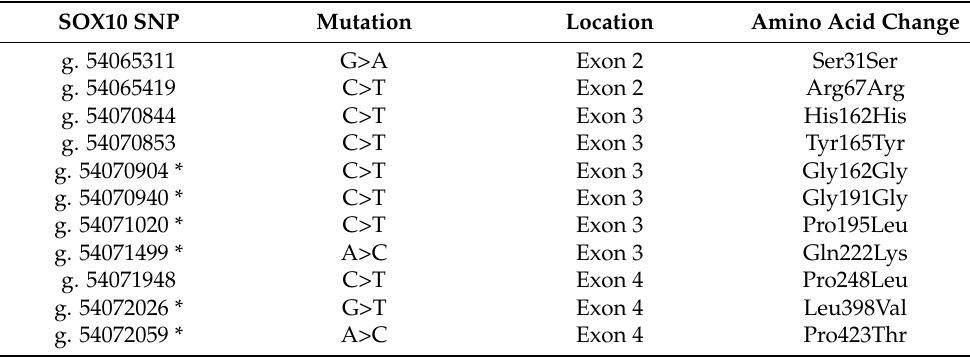
Table 2. Identified single-nucleotide polymorphisms (SNPs) in duck SOX10